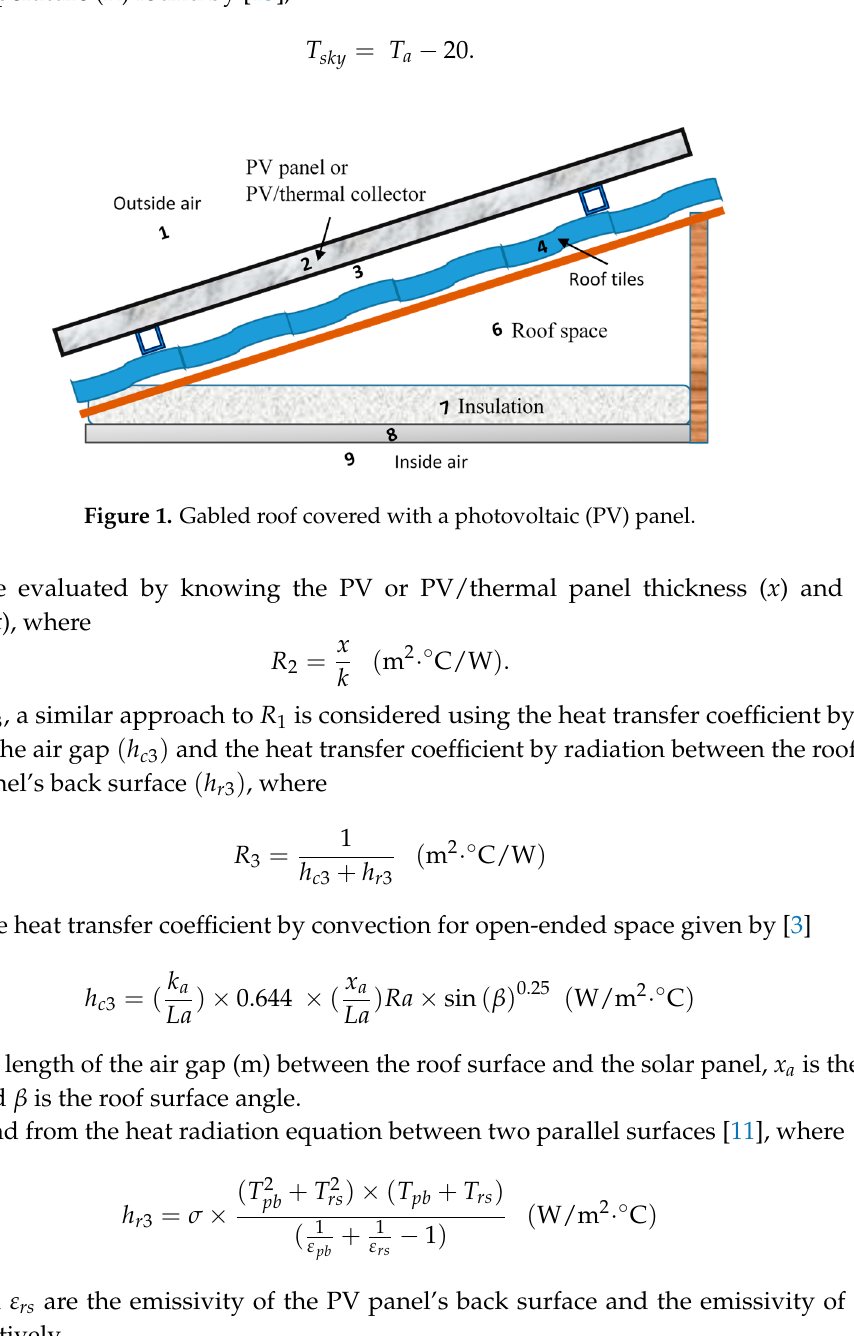
Figure 2. Thermal resistances of the gable roof.